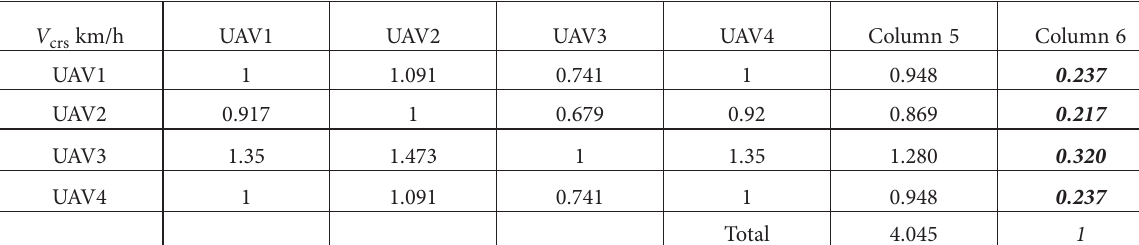
Table 9. Matrix of cruising speed